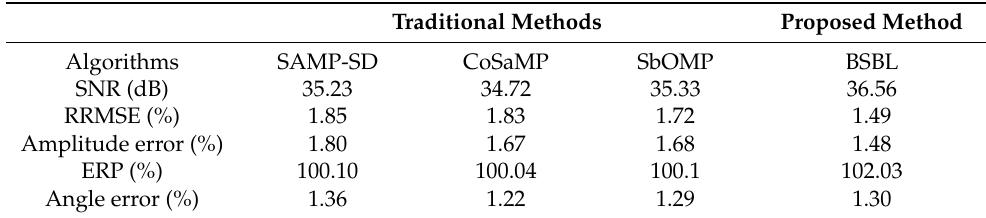
Table 12. Performance comparison of reconstruction algorithms (real-world fluctuant